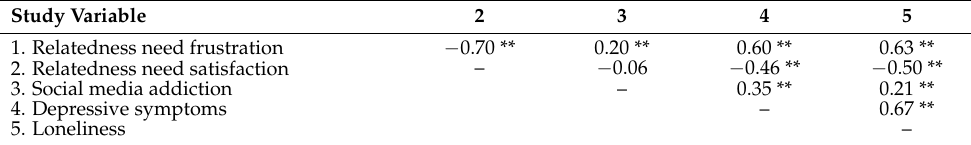
Table 2. Zero-order Pearson correlations among the study variables ( n = 1048). Study